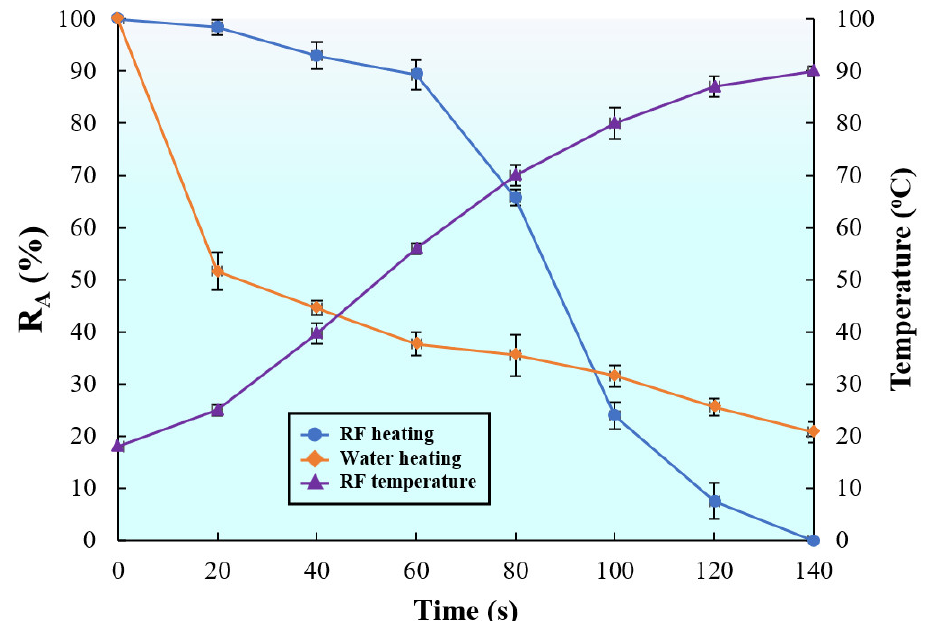
Figure 2. Comparison of effects on PME activity between RF heating and water heating. The electrode gap of the RF system was set as 90 nm. The temperature of the water bath was 90 °C.